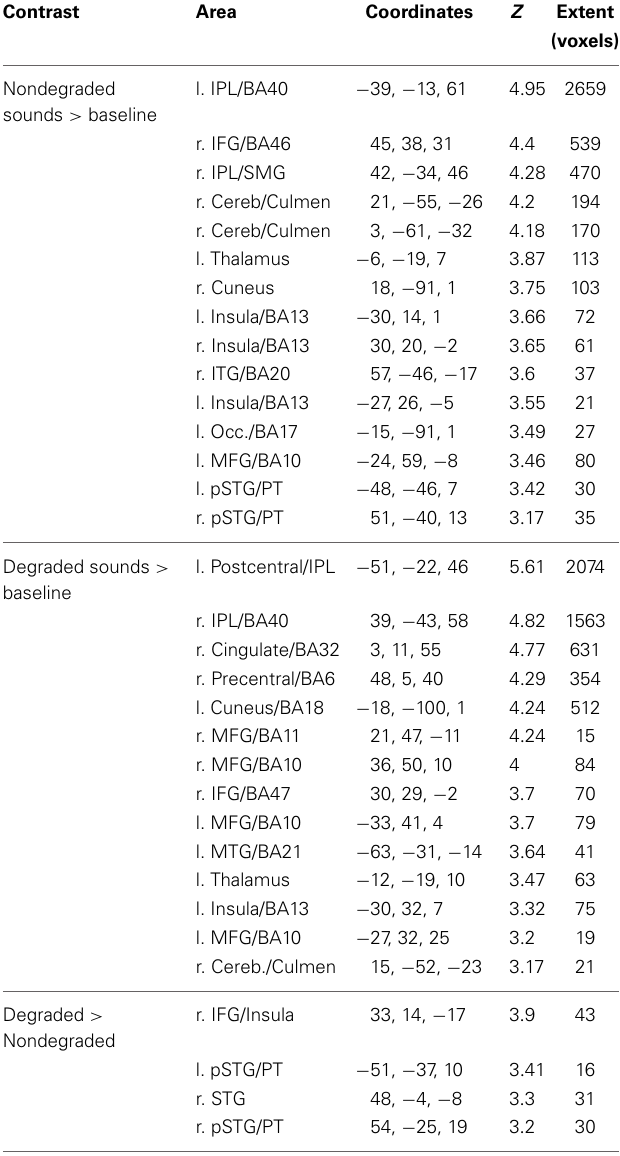
Table 2 | Significant clusters obtained from whole-brain analyses ( p < 0 . 005, extent threshold = 15) for the contrasts sounds > baseline in each condition, and the contrast degraded sounds > nondegraded